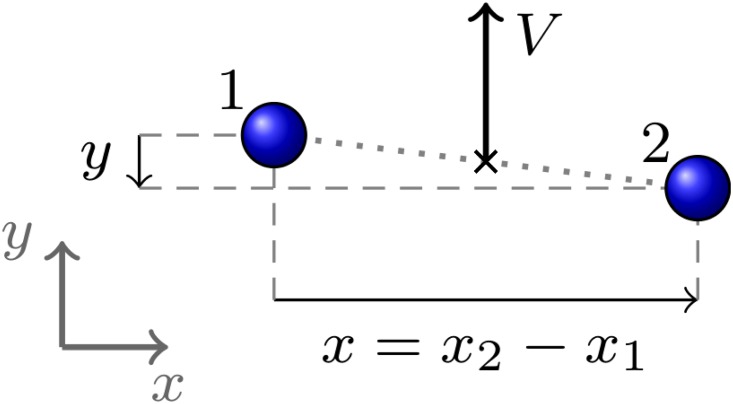
Group observables.